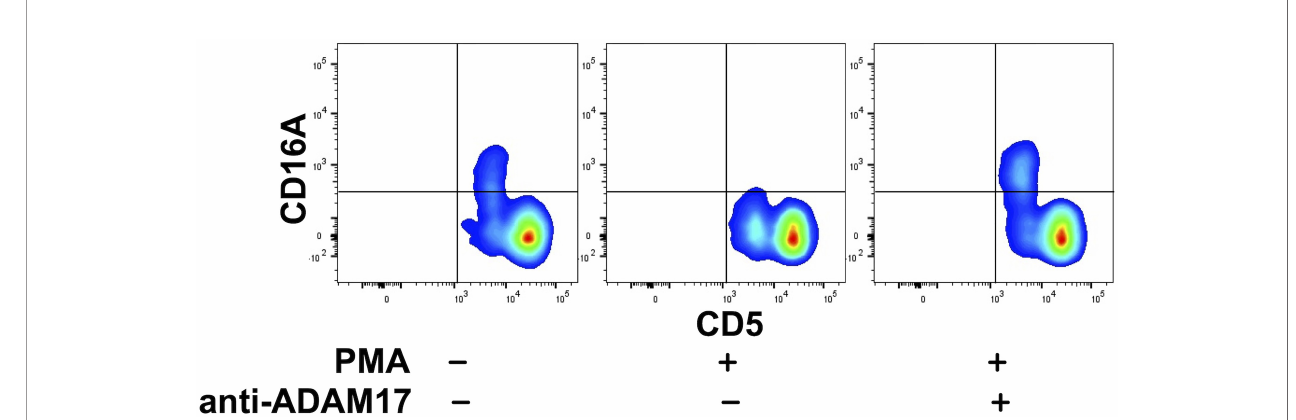
FIGURE 3 | Canine CD16A is downregulated by ADAM17 upon lymphocyte activation. Canine peripheral blood mononuclear cells were treated with or without PMA in the presence or absence of an ADAM17 function blocking mAb. Relative cell-staining levels of CD16A on CD5 dim or CD5 bright cells were determined by fl ow cytometry. All density plots show representative data of three independent experiments using leukocytes from separate